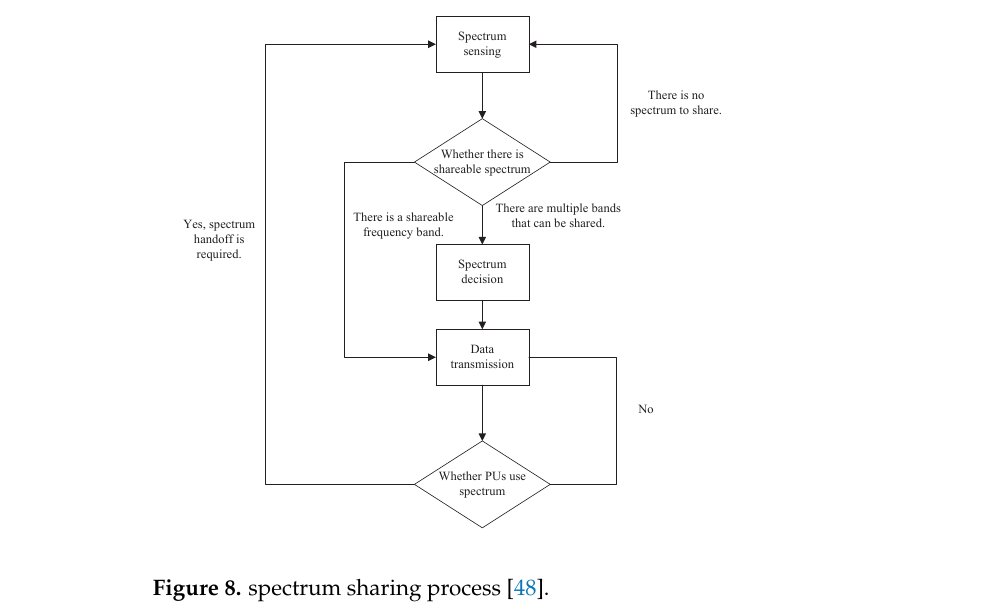
Figure 8. spectrum sharing process [48].